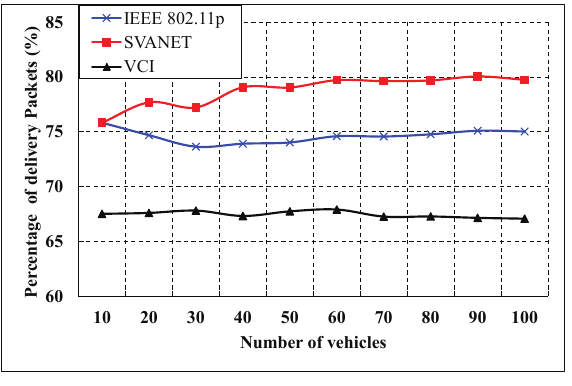
Figure 17. The number of selected leaders for different numbers of vehicles.